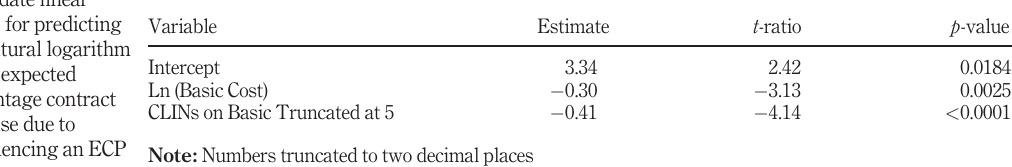
Table X. Final linear model for predicting the natural logarithm of the expected percentage contract